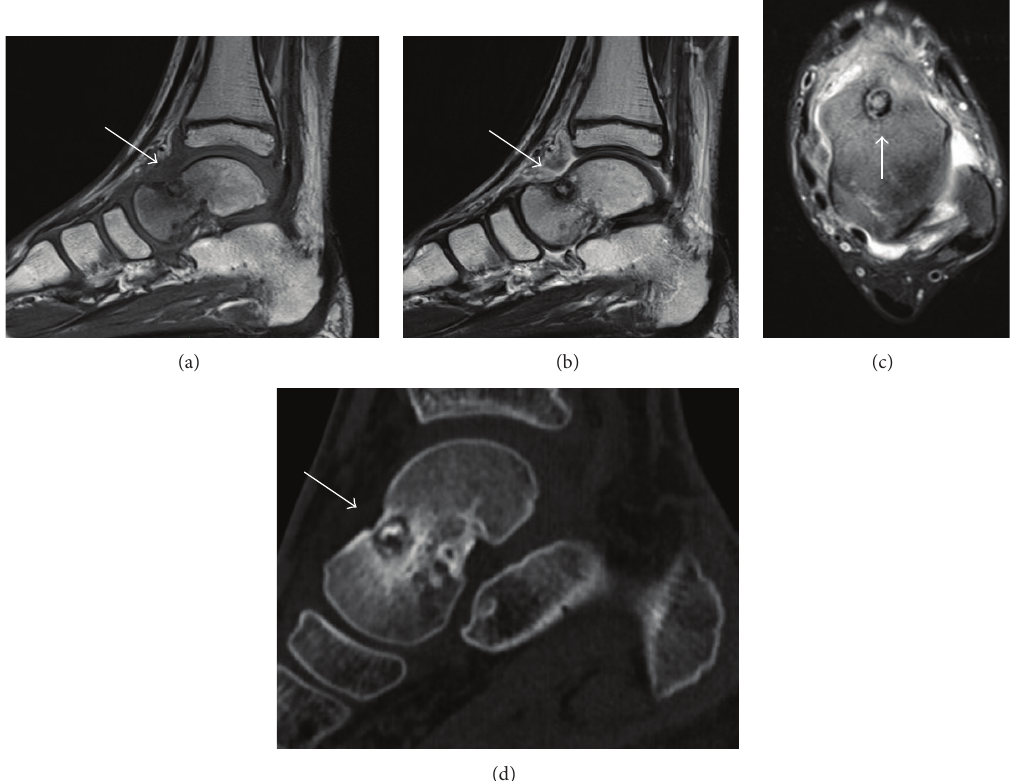
Figure 4: Same patient as in Figure 3. (a–c) MRI of the left ankle demonstrates the talar neck nidus, surrounded by abundant oedema and synovial inflammation ((a) sagittal T1-WI, (b) sagittal T2-WI, and (c) axial fat saturated PD-WI). (d) CT-scan of the left ankle also demonstrates the talar neck